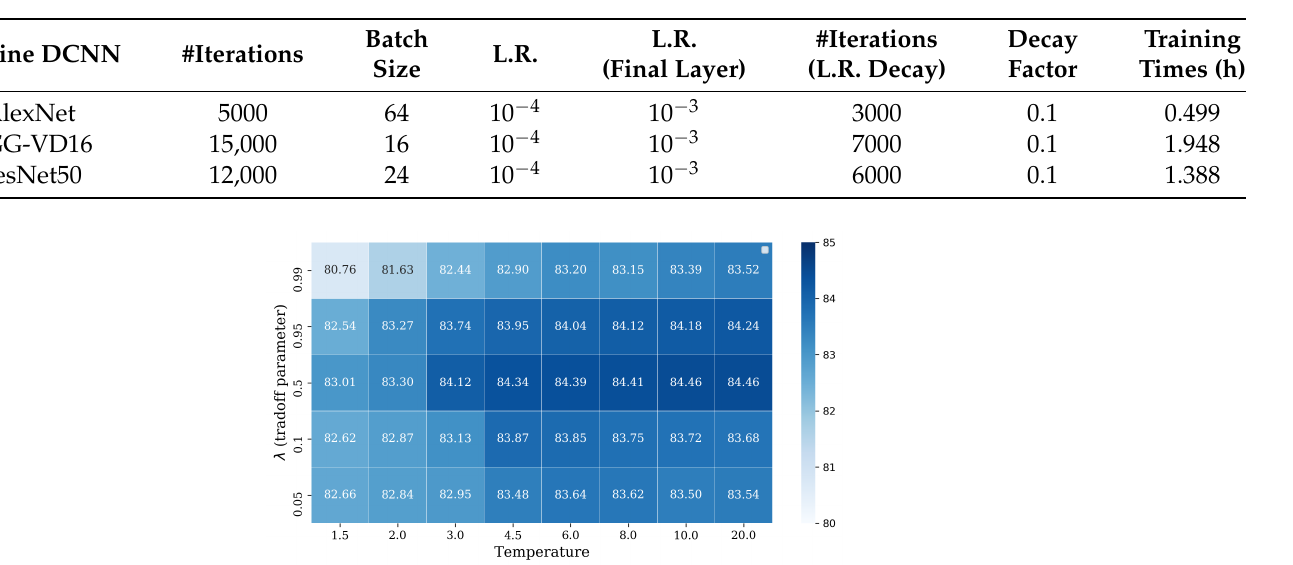
Table 4. Parameters utilized for models with different baseline DCNNs on the NWPU data set.